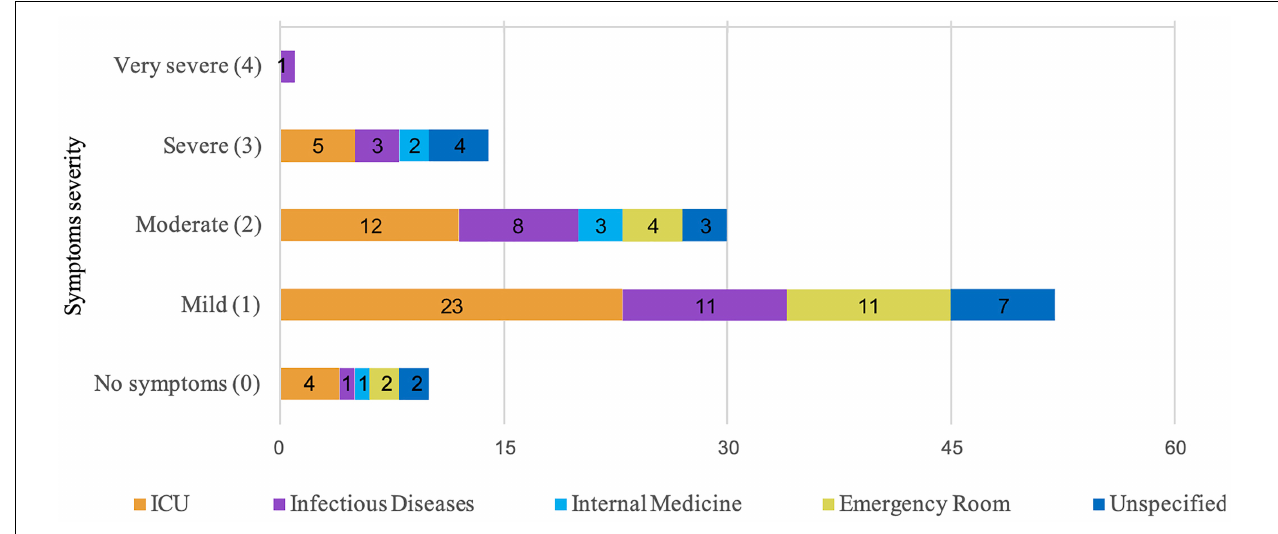
FIGURE 1 | National stressful events survey PTSD short scale (NSESSS) results according to severity of symptoms and place of